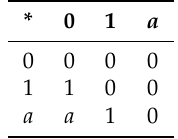
Table 2. Cayley table for the binary operation “ ∗